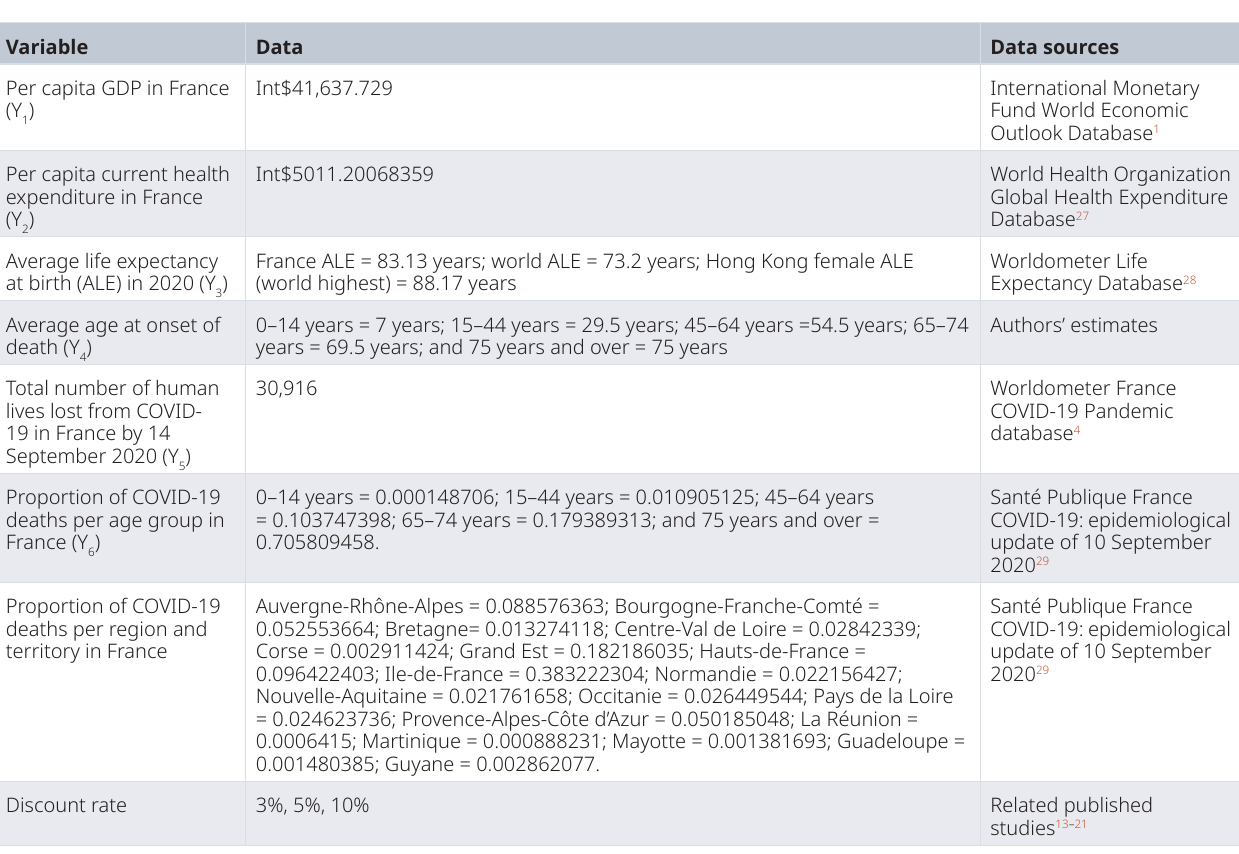
Table 3. Data and data